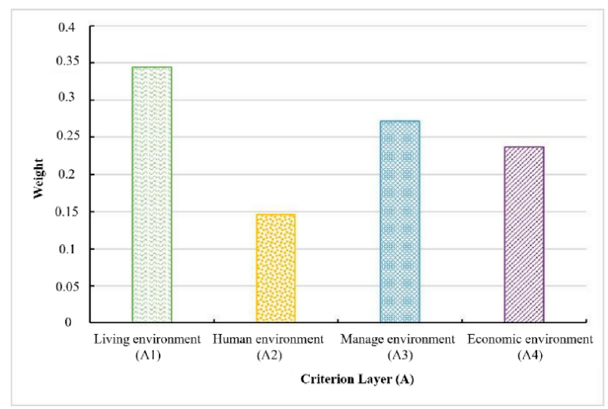
Figure 8. The weights in criterion layer.